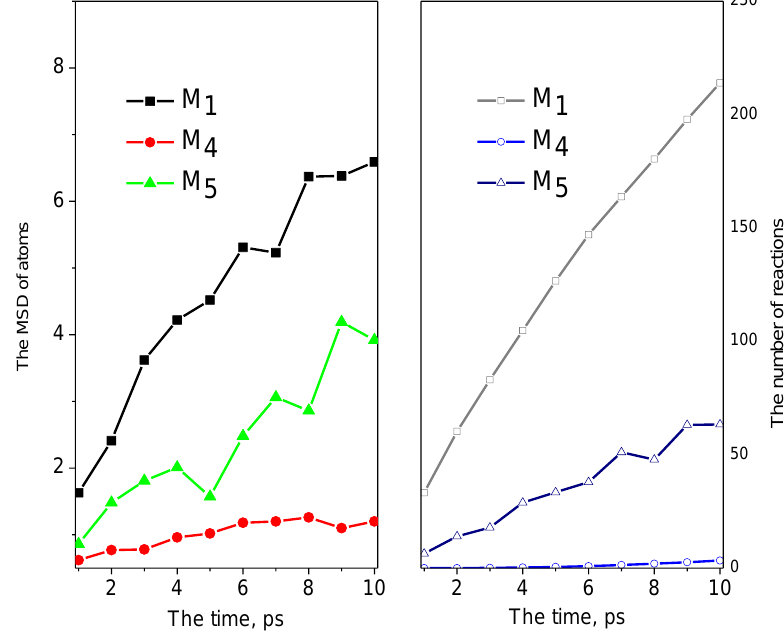
Figure 5. The mean number of reactions per atom (right) and MSD for the configuration (left) at ambient pressure